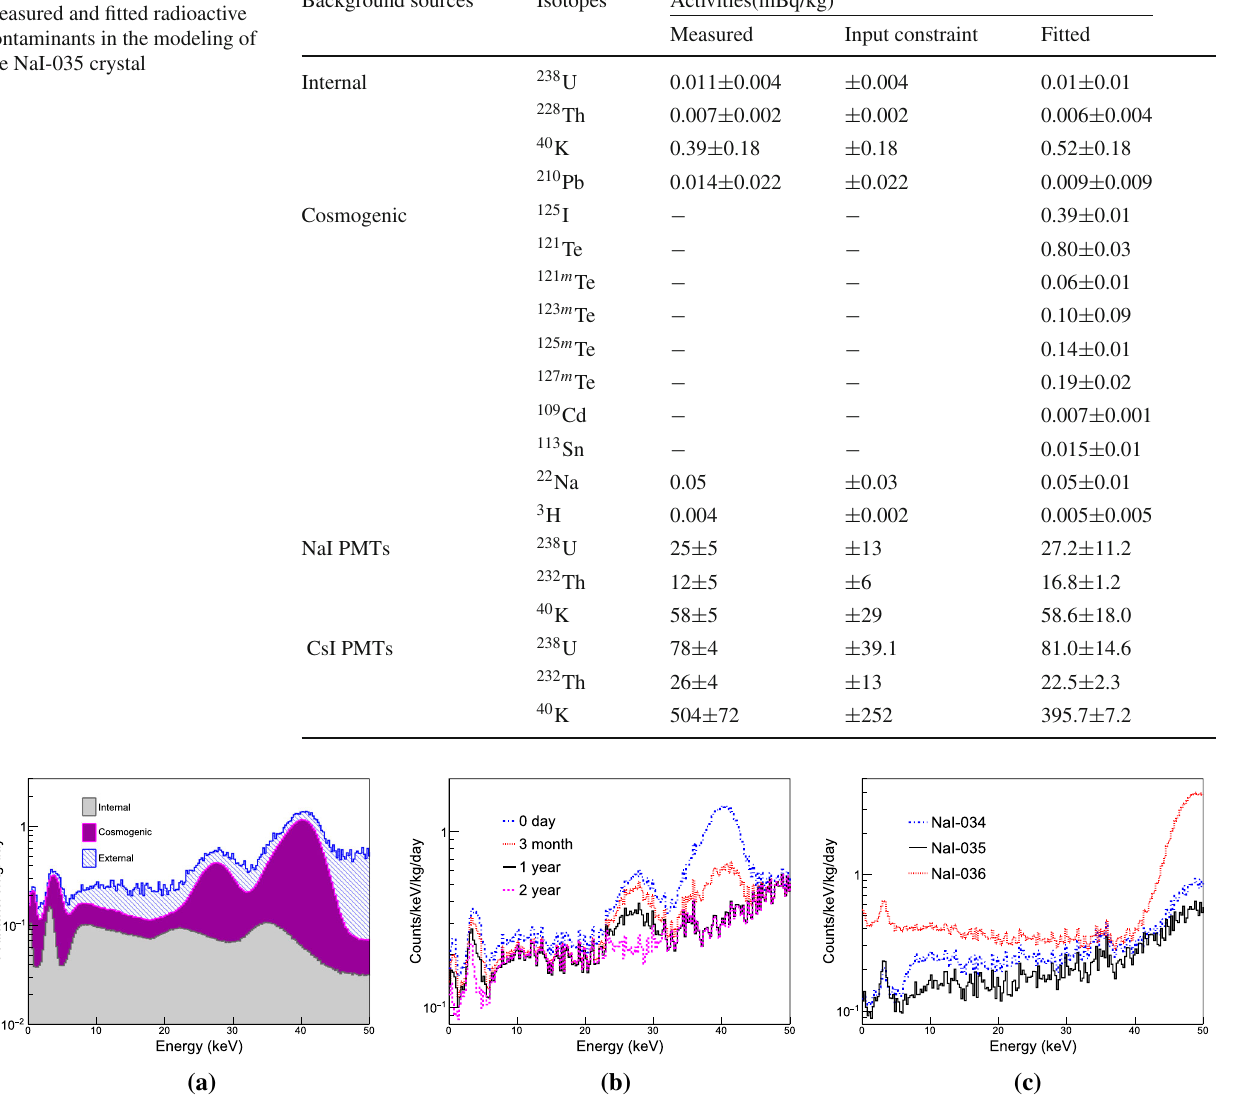
Fig. 12 a The expected background spectrum of a COSINE-200 crys- tal for low-energy single-hit events assuming the same internal and cosmogenic radioisotopes as NaI-035 but, installed in the COSINE- 100 shield with an enlarged crystal size (12.5 kg). b The time evo- lution of the background level due to decays of short-lived cosmo- genic radioisotopes after 0 days (blue-dashed-dotted line), 3 months